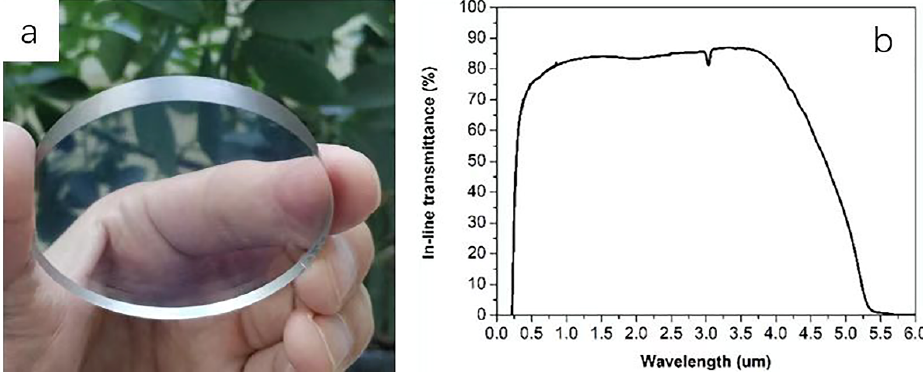
Figure 7. ( a ) Li: AlON transparent ceramic ( Φ 55 mm × 6 mm) and ( b ) the optical transmittance.